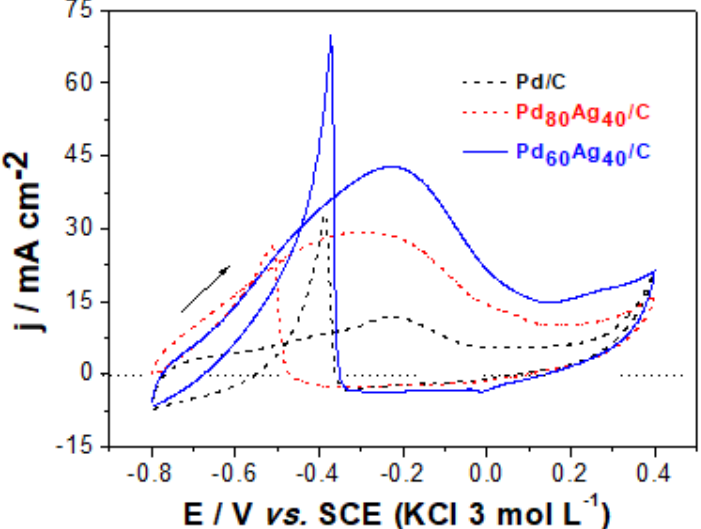
Figure 4. Cyclic voltammograms of the electrocatalysts 40% Pd-based/C in N 2 -purged KOH 1.0 mol L − 1 /ethanol at scan rate of 20 mV s − 1 .